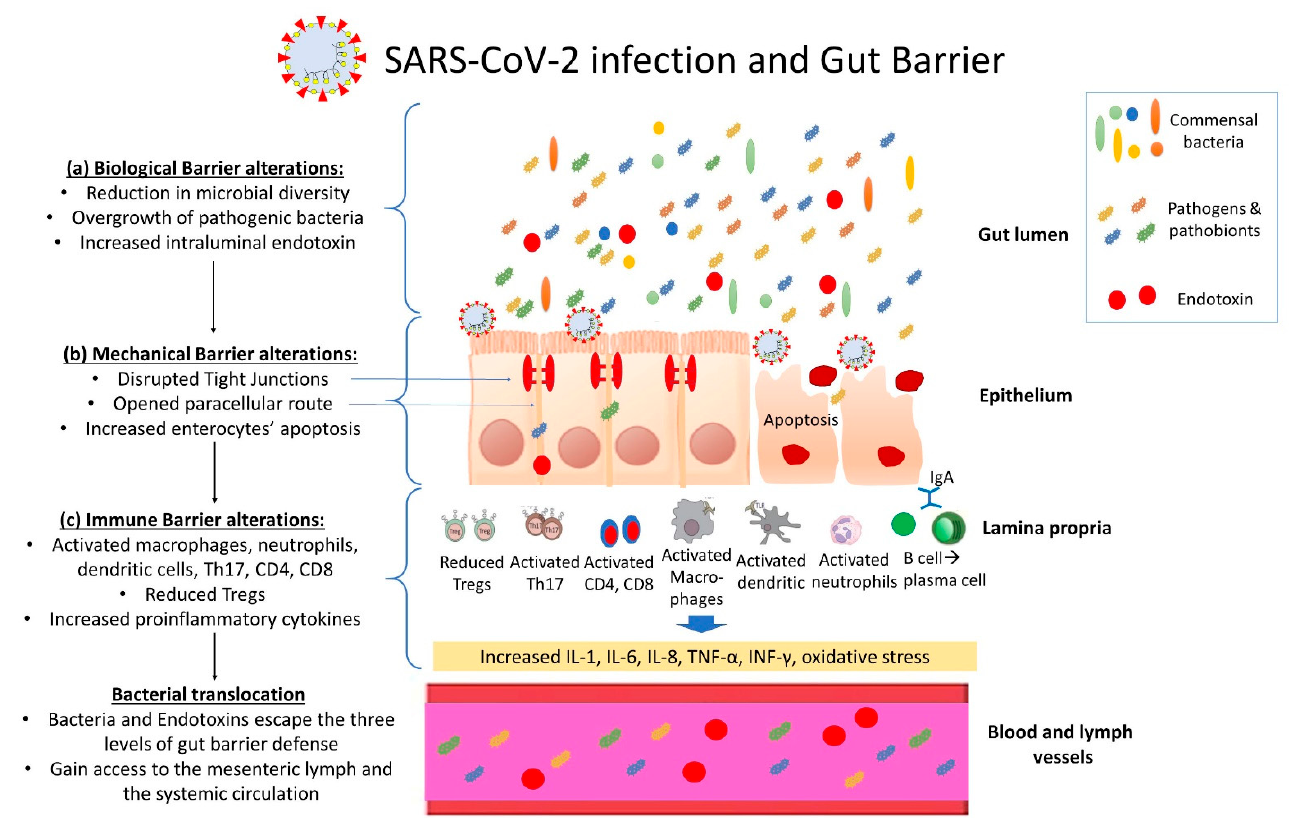
Figure 1. Overview of intestinal barrier dysfunction in SARS-CoV-2 infection: SARS-CoV-2 in- fection induces a multifactorial disruption of intestinal barrier integrity by negatively affecting all of its major levels of defense; (a) The biological barrier, consisting of the commensal gut microbiota, is disrupted with reduction in microbial diversity and beneficial bacteria population such as butyr- ate-producing firmicutes concurrently with overgrowth of pathogenic bacteria (dysbiosis), while luminal endotoxin is increased. Intestinal dysbiosis through a continuous crosstalk with the intesti- nal epithelium negatively affect the integrity of the mechanical and immune barriers. (b) The me- chanical barrier, which is comprised of the intestinal epithelial cells and their close interconnections (tight junctions—TJs), is also compromised. SARS-CoV-2 disrupts enterocytes’ TJs thus opening the paracellular route and additionally promotes intestinal epithelial cells apoptosis. (c) The intestinal immune barrier is characterized by activation of mucosal CD4(+) and CD8(+) T cells, Th17 cells, decreased T-regulatory cells and activated neutrophils, dendritic cells and macrophages, leading to overproduction of proinflammatory cytokines and reactive oxygen species, associated with tissue injury and further disruption of the integrity of the mechanical barrier. Through this dysfunctional intestinal barrier, microbes and endotoxin can escape the intestinal lumen and gain access to the systemic circulation (bacterial and endotoxin translocation).